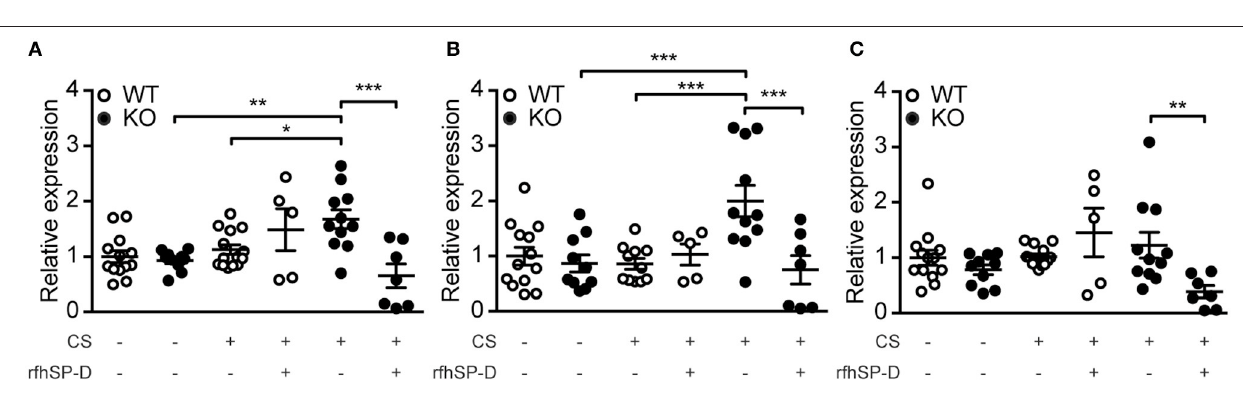
FIGURE 7 | Recombinant SP-D administration reverses pulmonary overexpression of ceramide synthases (CerS) in cigarette smoke (CS)-exposed mice. Lung mRNA levels of (A) CerS2, (B) CerS5, and (C) CerS6 are increased after acute CS exposure in SP-D-deficient mice and are normalized by treatment with recombinant fragment of human SP-D (rfhSP-D). n = 5–14. * p < 0.05, ** p < 0.01, *** p < 0.001, analyzed by one-way ANOVA followed by Bonferroni’s